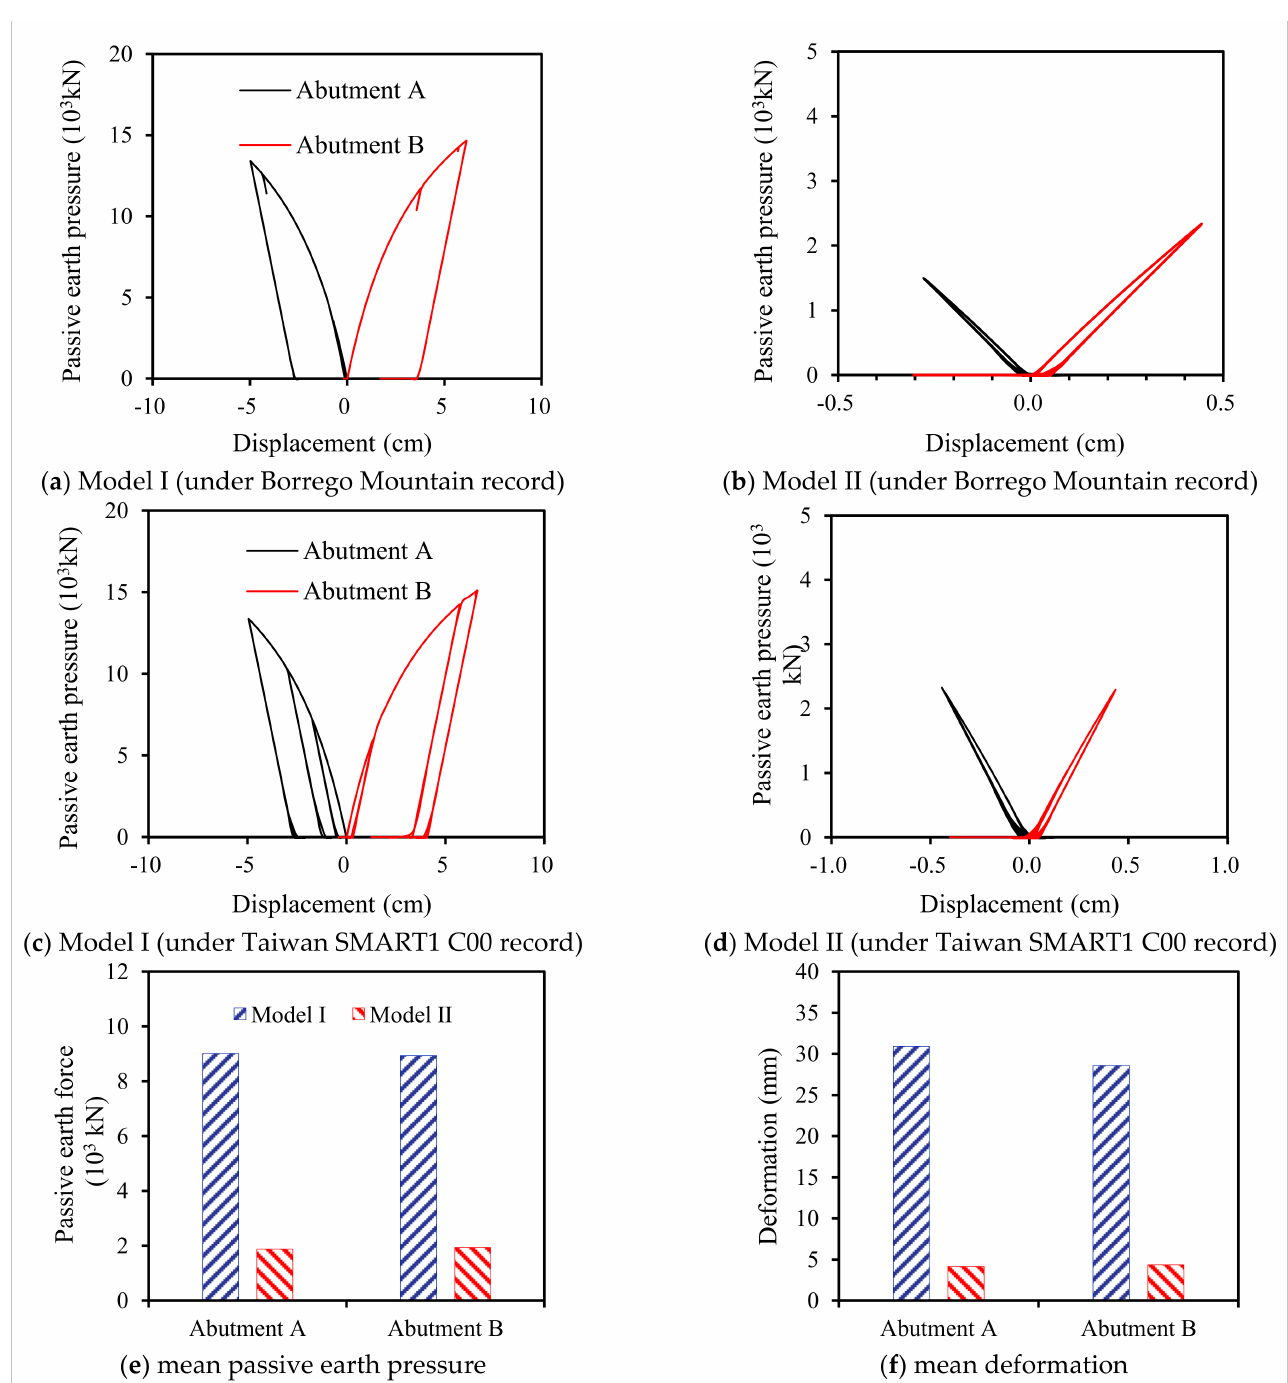
Figure 11. Backfill